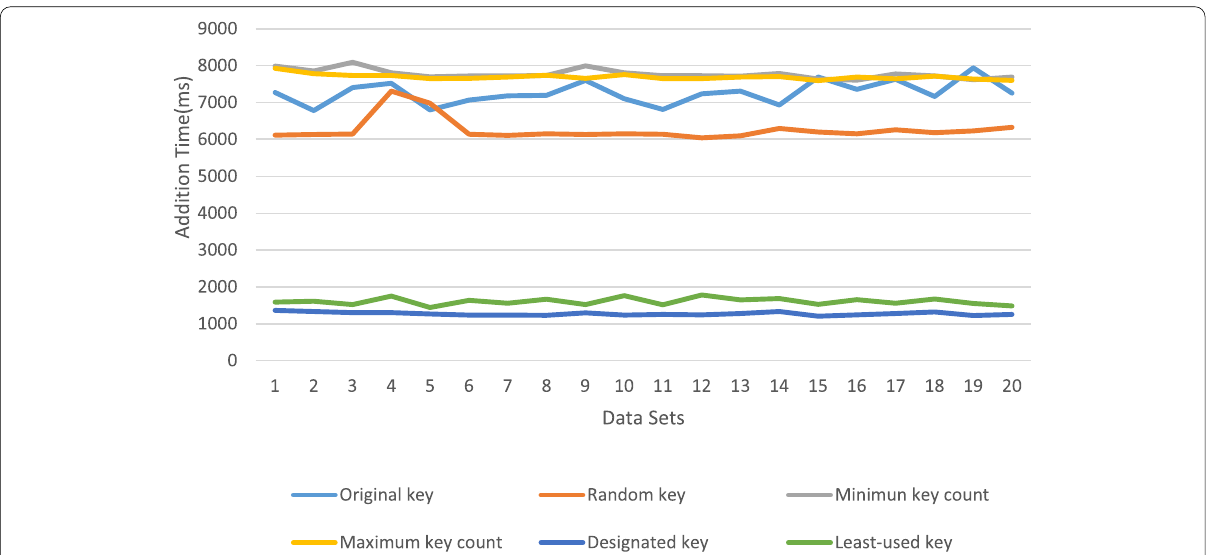
Fig. 19 Addition time on full index models generated using the six key selection methods with unequal appearing probabilities of parameters in service